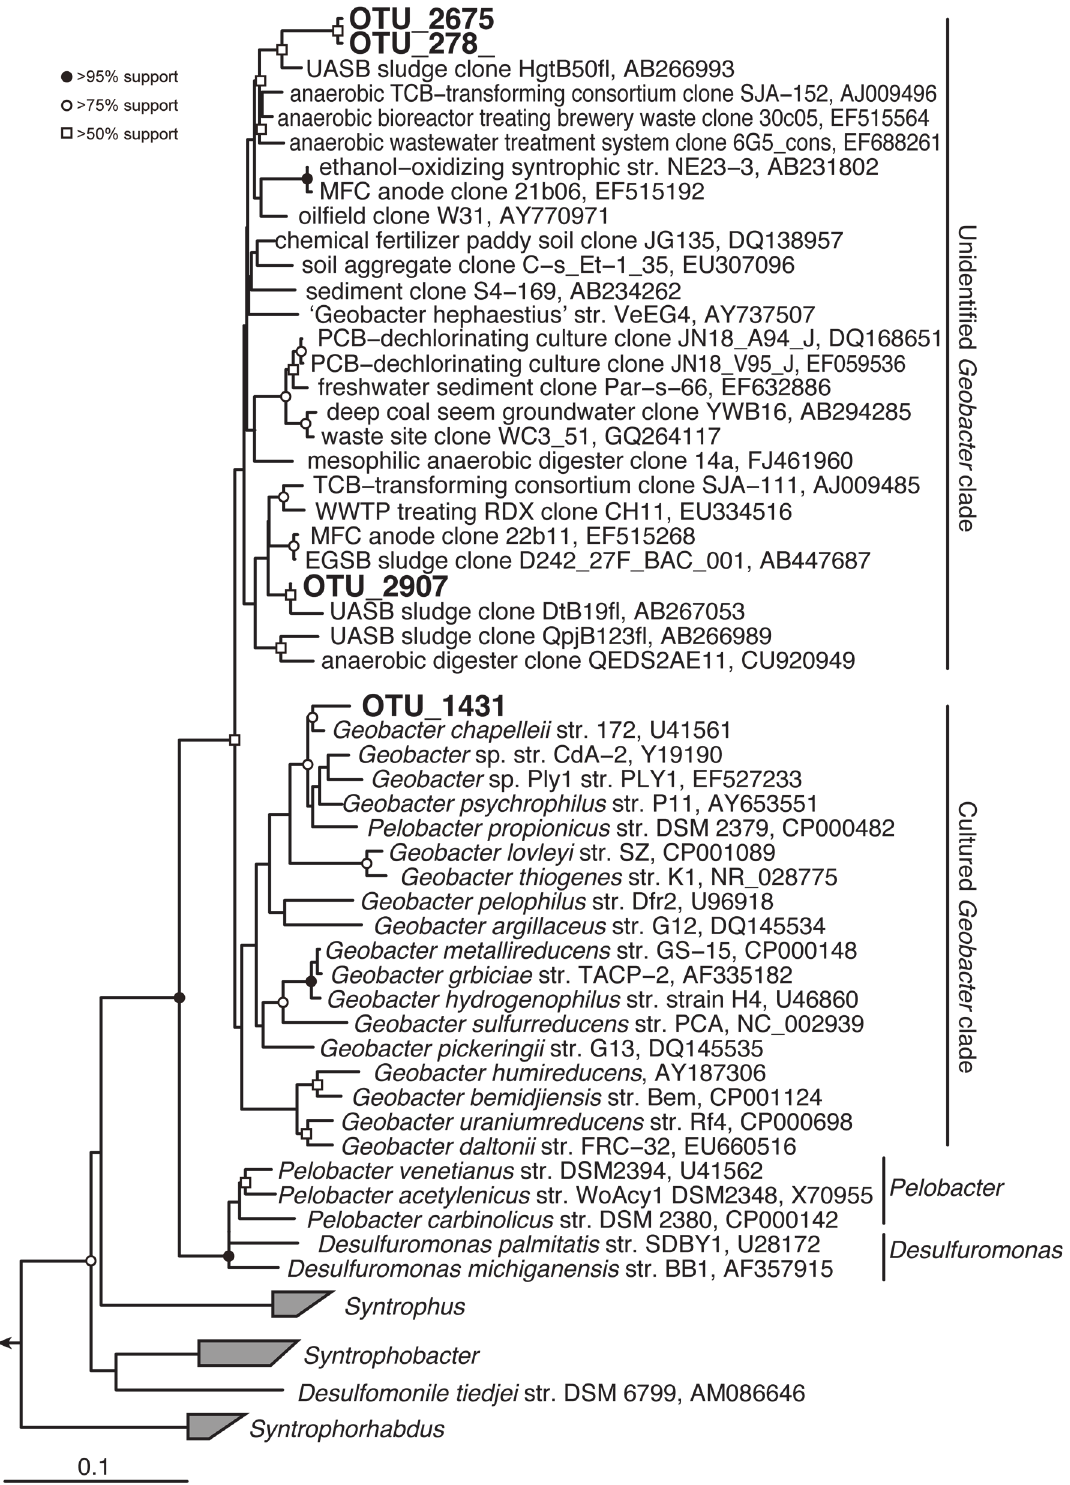
Fig 6. Distance matrix tree of 16S rRNA gene sequences assigned to the Geobacter retrieved from anaerobic reactors based on the neighbor- joining method. Boldface indicates the sequences obtained in this study. The 16S rRNA gene sequences of Thermodesulfobacterium commune DSM 2178 (AF418169), Thermodesulfobacterium hveragerdense DSM 12571 (NR_029311), and Thermodesulfobacterium hydrogeniphilum DSM 14290 (NR_025146) were used as outgroup. The bar indicates 10% base substitution. Branching points supported probabilities > 95%, > 75%, and > 50% by bootstrap analyses (based on 1,000 replicates) are indicated by solid circle, open circles, and open square, respectively.